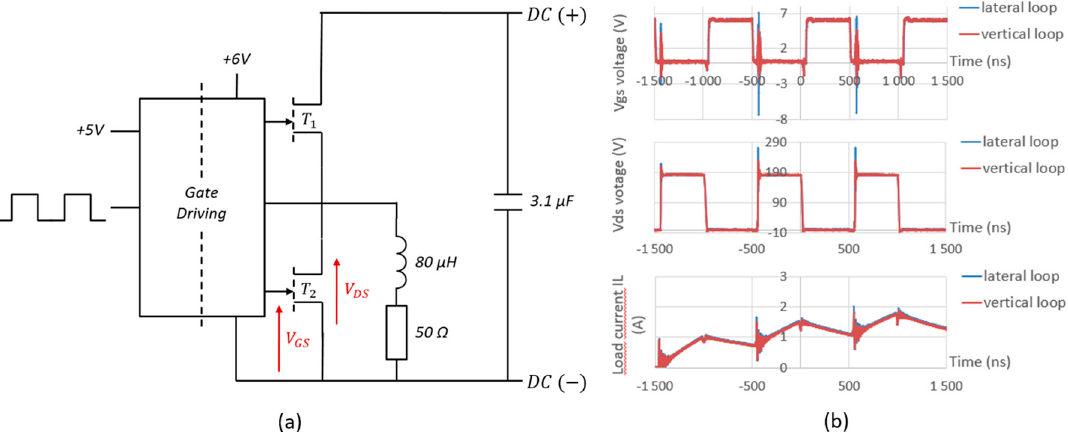
Figure 23. Switching waveforms measurement: ( a ) schematic representation of the test setup; ( b ) voltage waveforms of T 2 and load current.